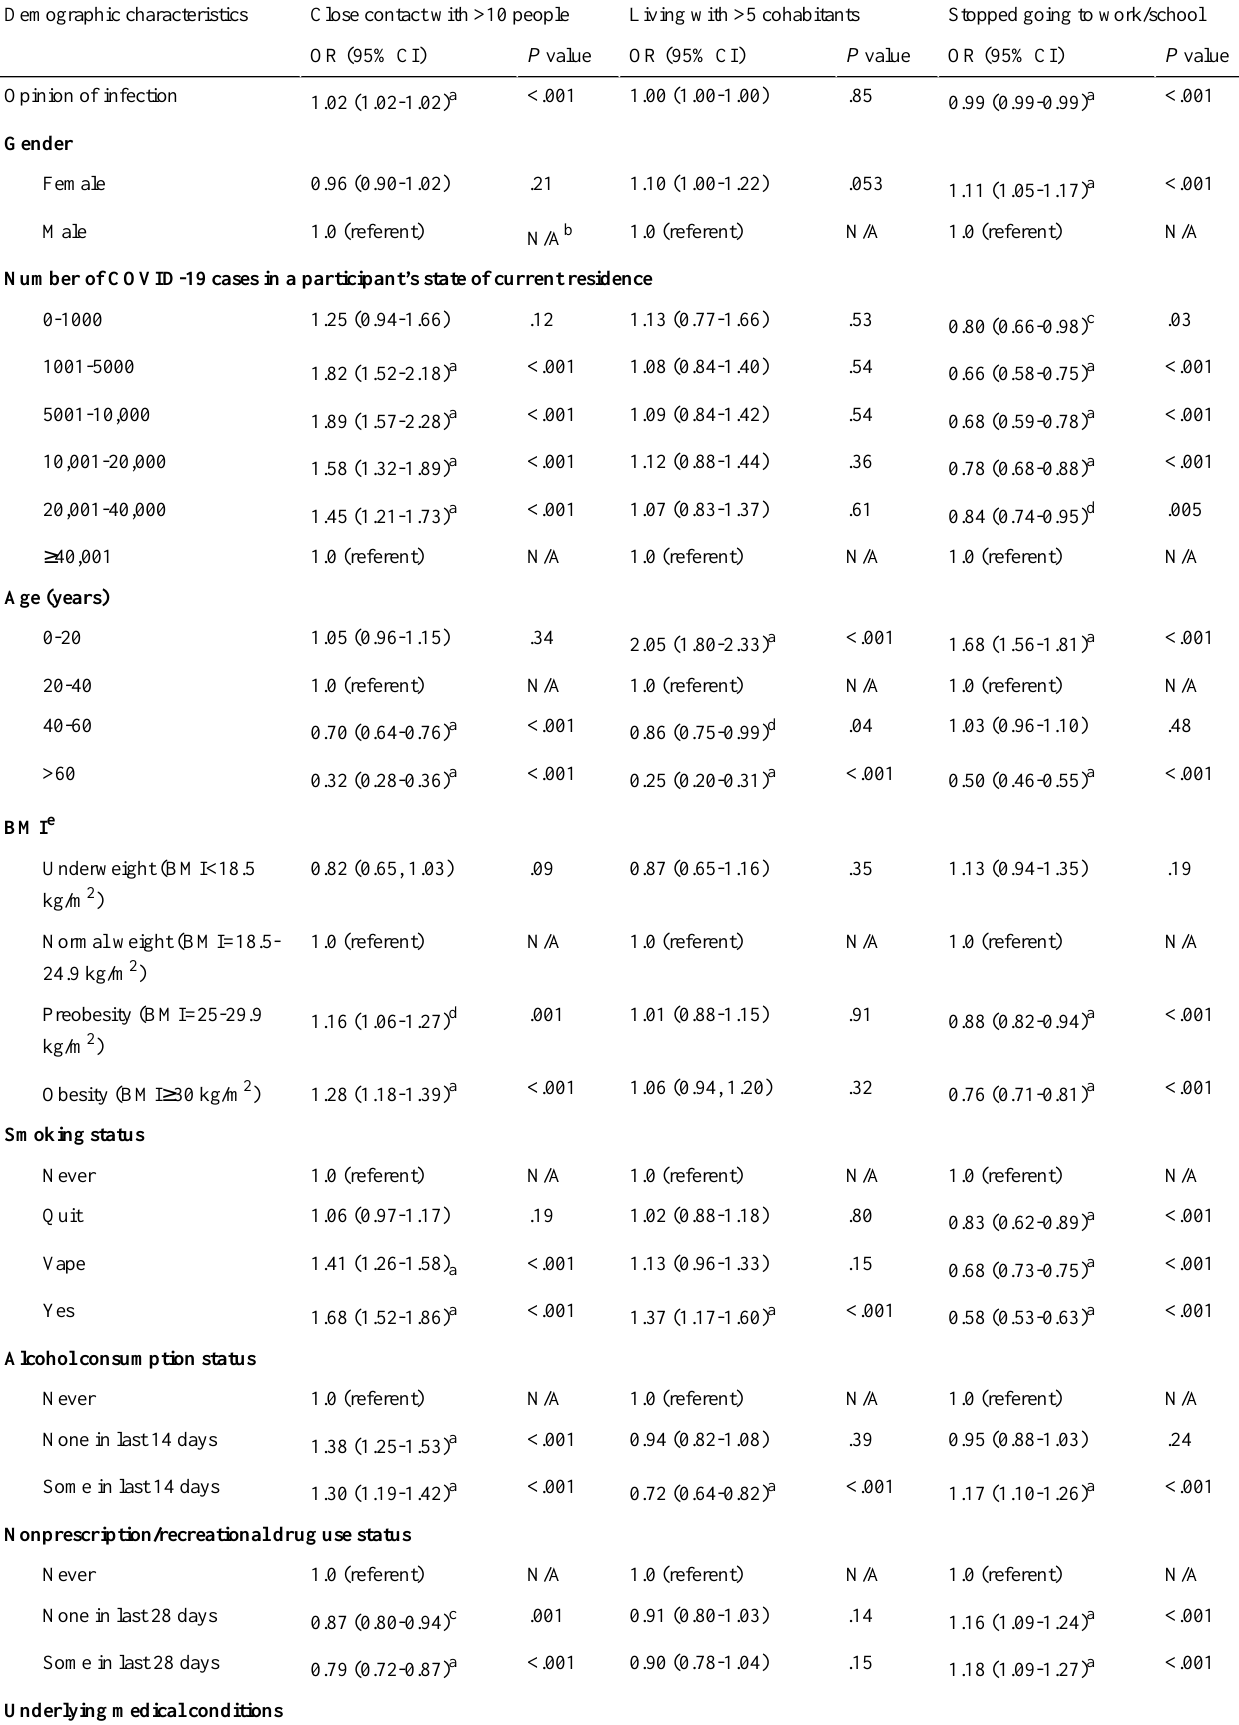
Table 4. Results of the binary logistic regression analysis of factors that were significantly associated with environmental factors.